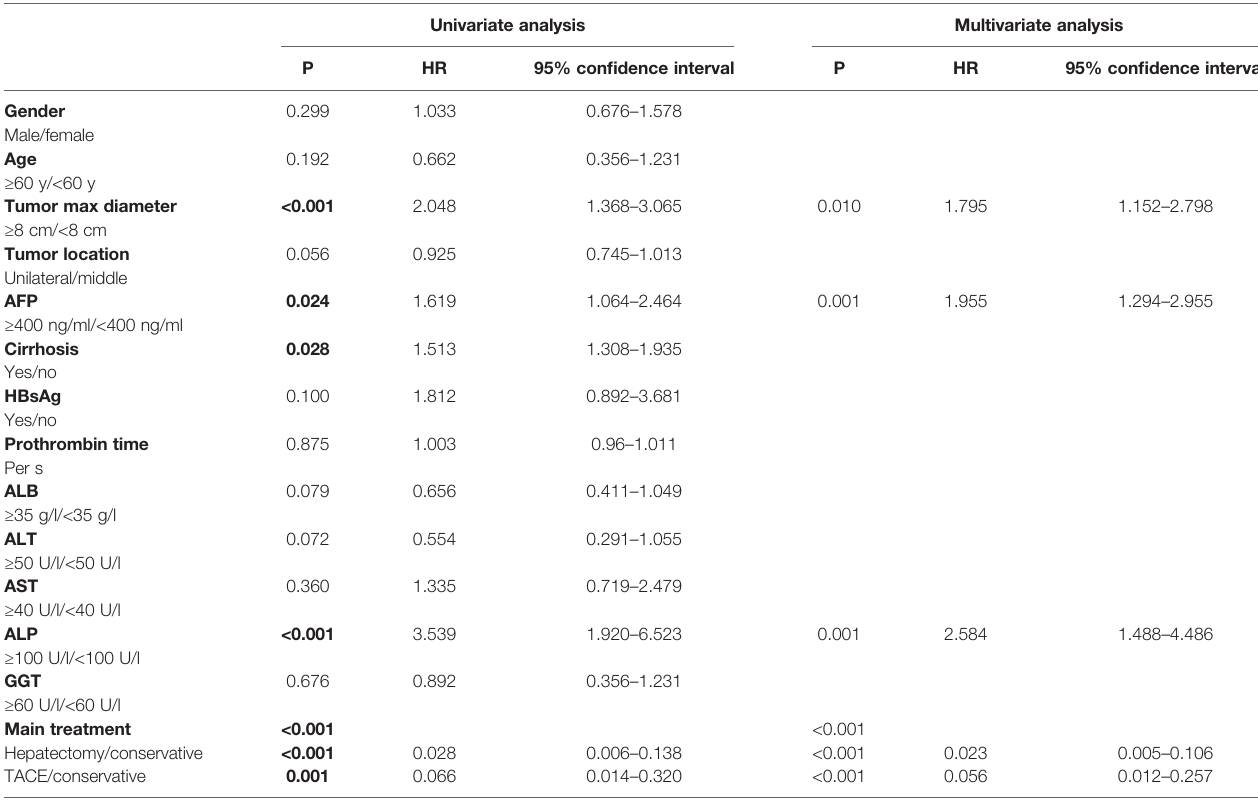
TABLE 2 | Univariate and multivariate analyses of overall survival in BCLC 0/A stage rHCC patients. Univariate analysis Multivariate